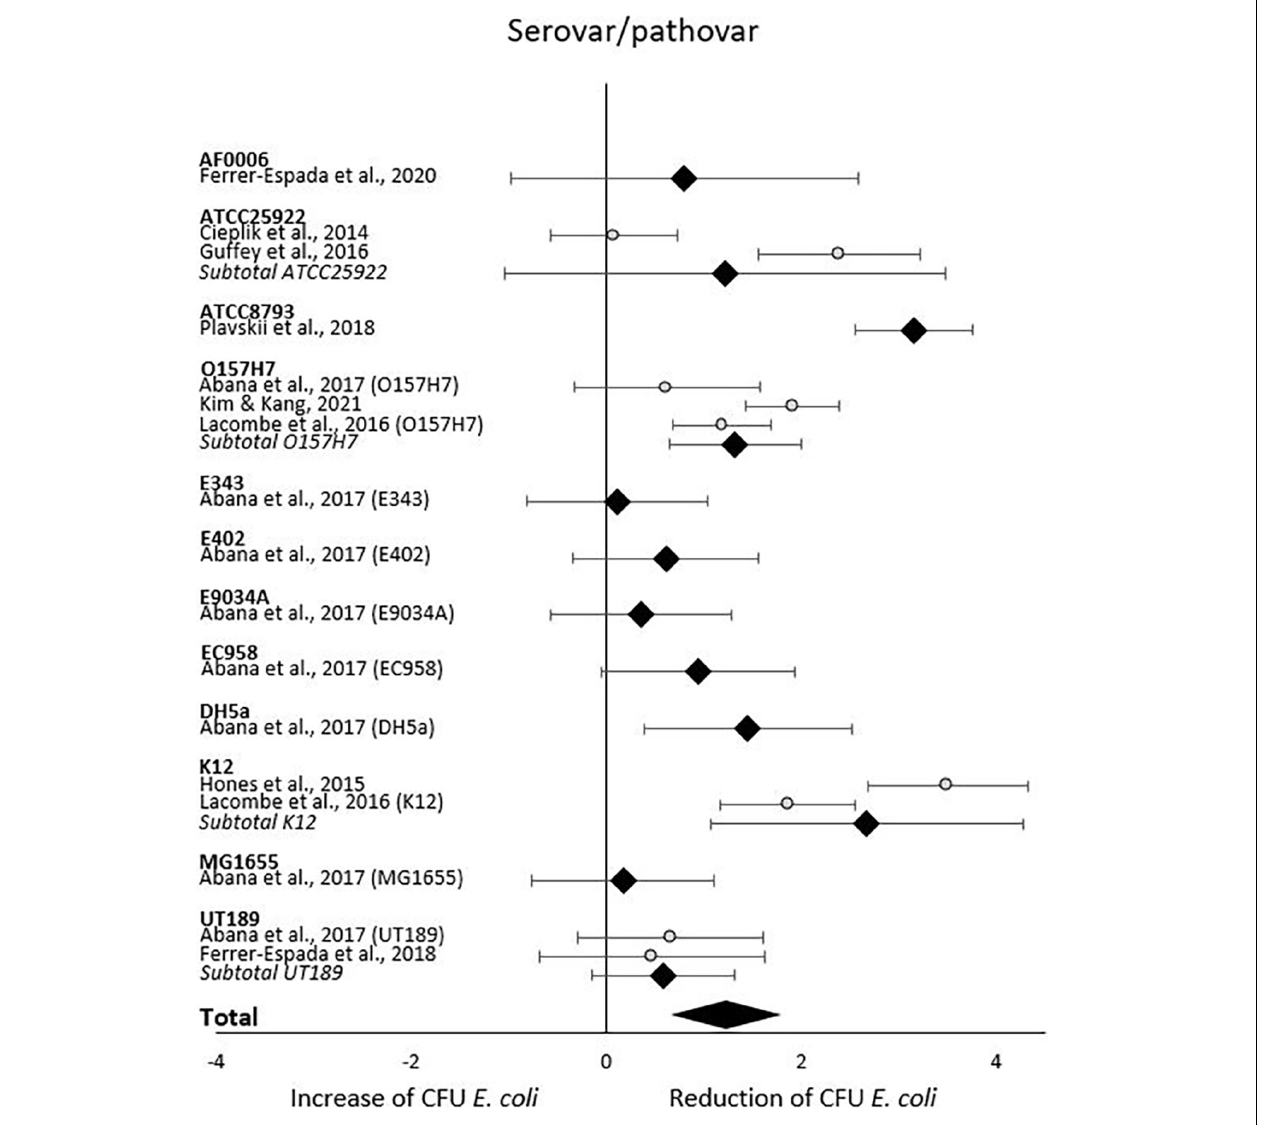
FIGURE 7 | Forest plot of reduction of E. coli post blue light exposure by